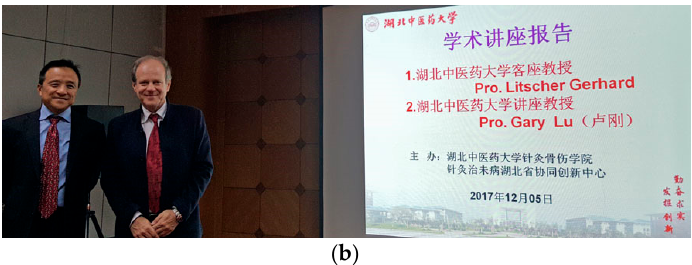
Figure 33. Hubei University of Chinese Medicine. ( a ) First row from left to right: Professor Gary Lu (2nd from left), Professor Gerhard Litscher, Professor Wang Hua, and Professor Liang Fengxia; ( b ) Professor G. Lu (left) and Professor G. Litscher. Wuhan, China, 5 December 2017.